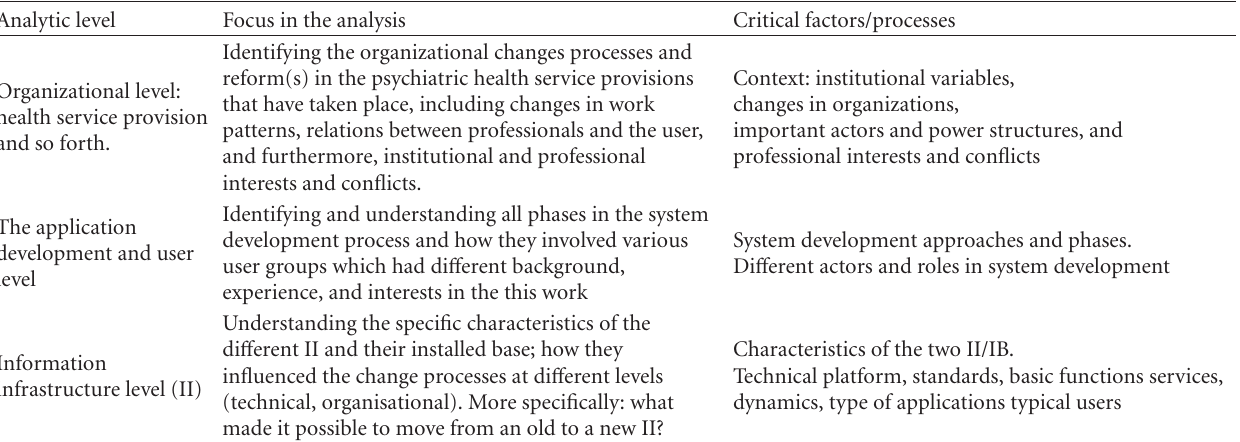
Table 1: Research framework.